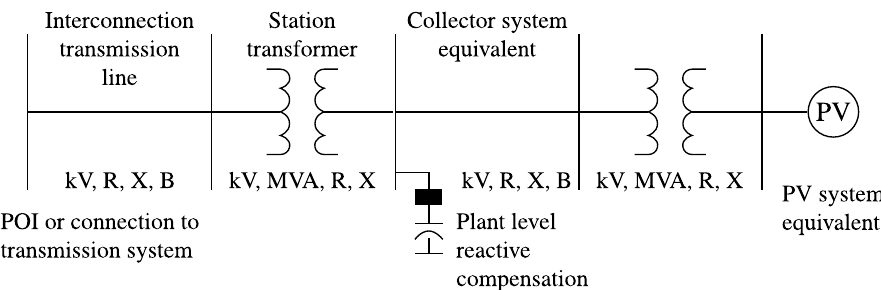
Figure 1. Single machine representation of a solar PV